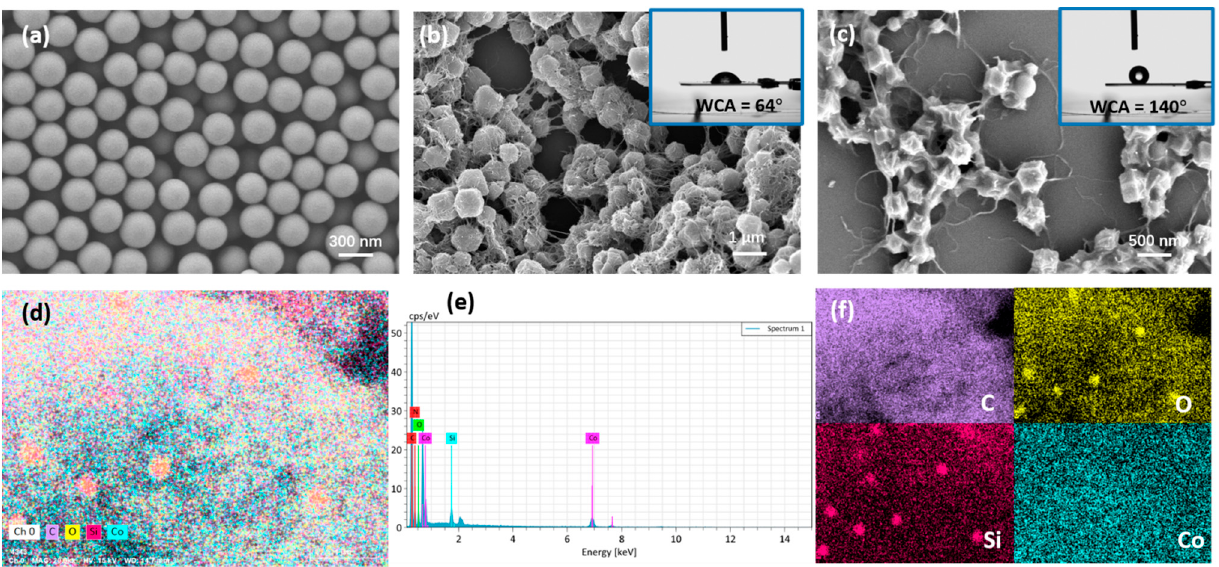
Figure 3. FE-SEM image of the silica particles ( a ); FE-SEM images and WCA photographs (inset) of Co-MOF/CNTs ( b ) and Co-MOF/CNTs/SiO 2 ( c ); element mapping images of Co-MOF/CNTs/SiO 2 ( d – f ).